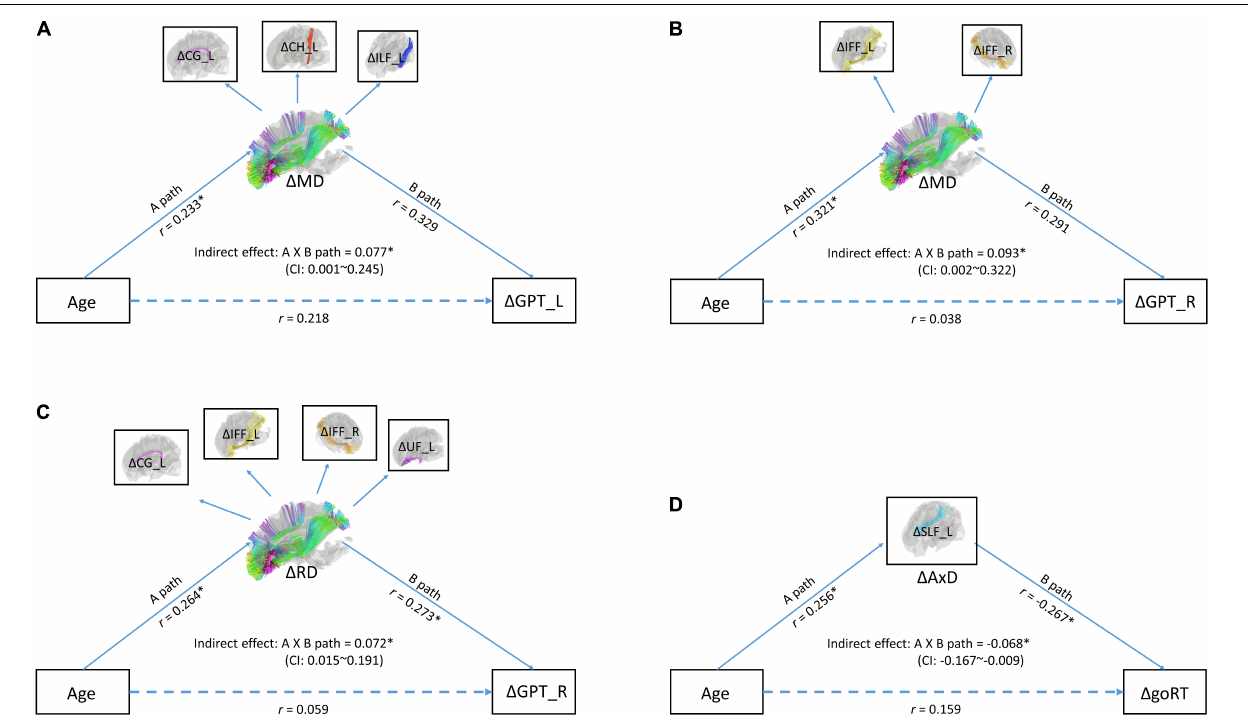
FIGURE 2 | (A) A mediation model with latent variables for age (at time point 1), (cid:49) MD (changes in mean diffusivity), and (cid:49) GPT_L (changes in processing speed). (B) A mediation model with latent variables for age (at time point 1), (cid:49) MD (changes in mean diffusivity), and GPT_R (changes in processing speed). (C) A mediation model with age (at time point 1), (cid:49) RD, and GPT_R. (D) A mediation model with age (at time point 1), (cid:49) AxD, and goRT (changes in processing speed). In these models, observed variables (shown in boxes) serve as independent variables and indicators of latent variables (shown in ellipses). Indirect effect between age and mixing cost was tested by the bootstrap method. Upper and lower bound of the 95% confidence interval was marked in the center of the model. GPT_L, Grooved Pegboard Test with the left hand; GPT_R, Grooved Pegboard Test with the right